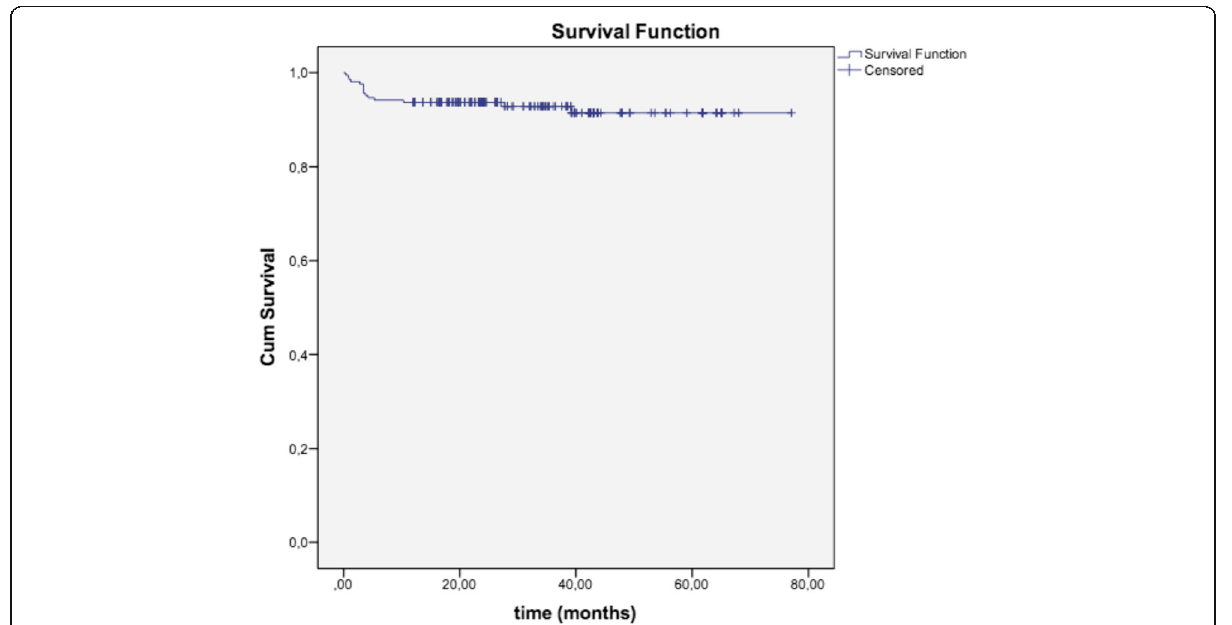
Fig. 1 On Kaplan-Meier survival estimates, the cumulative survival rate was